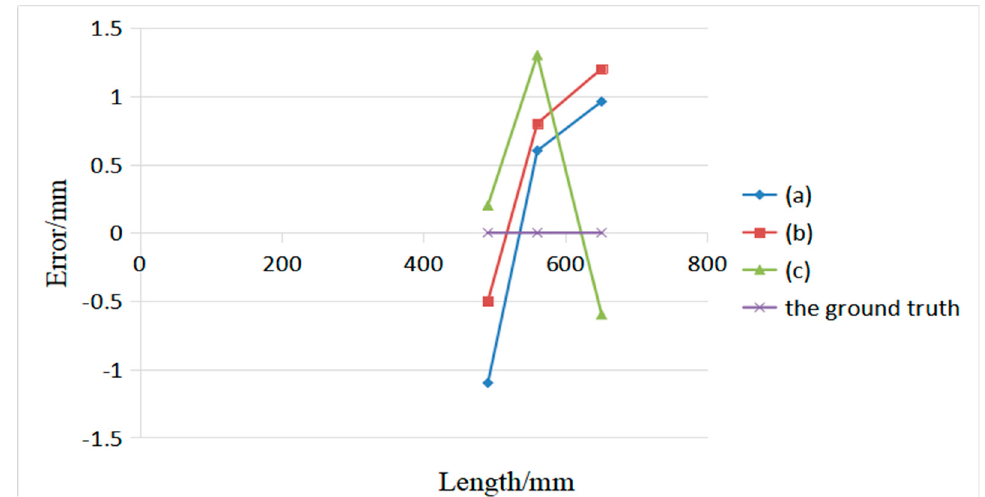
Figure 17. Measurement results of the box system in different scenarios.